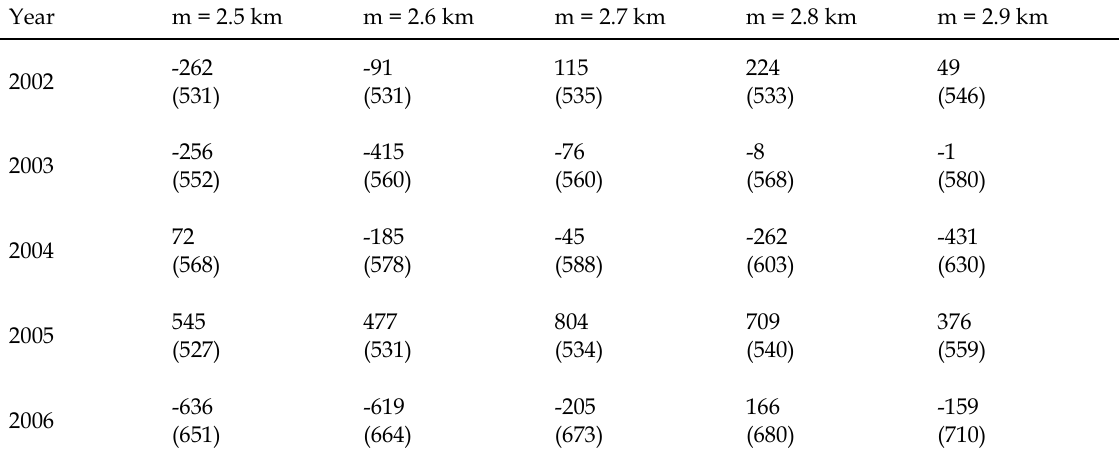
Table 4. Estimated post-treatment effect of improved job accessibility on commuting